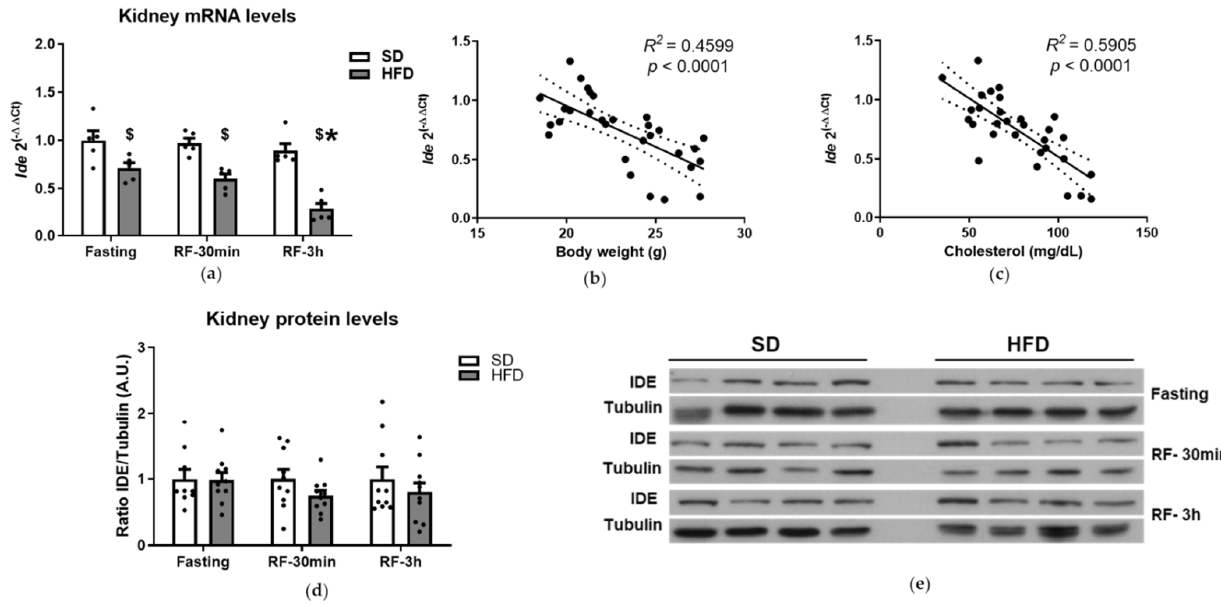
Figure 3. Transcriptional and posttranscriptional regulation of renal IDE. ( a ) Transcriptional regulation of Ide . Total mRNA was isolated and quantified from the kidney tissues of mice fed an SD or HFD during fasting or refeeding conditions. Data are the means ± SEM. N = 5 mice per condition. * p < 0.05 vs. fasting by ANOVA. $ p < 0.05 vs. SD by ANOVA. Regression analyses. Bivariate analyses were performed using data from mice fed an SD and HFD, during fasting and refeeding conditions. ( b ) Correlation between renal Ide gene expression and body weight. ( c ) Correlation between renal Ide gene expression and plasma cholesterol levels. The R 2 and the statistical significances ( p ) values are indicated in the figure. Regulation of IDE protein levels. IDE protein levels in lysates from kidneys of mice fed an SD or HFD, during fasting or refeeding conditions, were resolved by Western blots and quantified by densitometric analyses using full blots (Appendix A, Figure A2b). Then, data were plotted for each nutritional status and diet ( d ). Data are the means ± SEM. N = 10–11 mice per condition. ( e ) Representative image illustrating renal IDE levels showed in “panel d”.